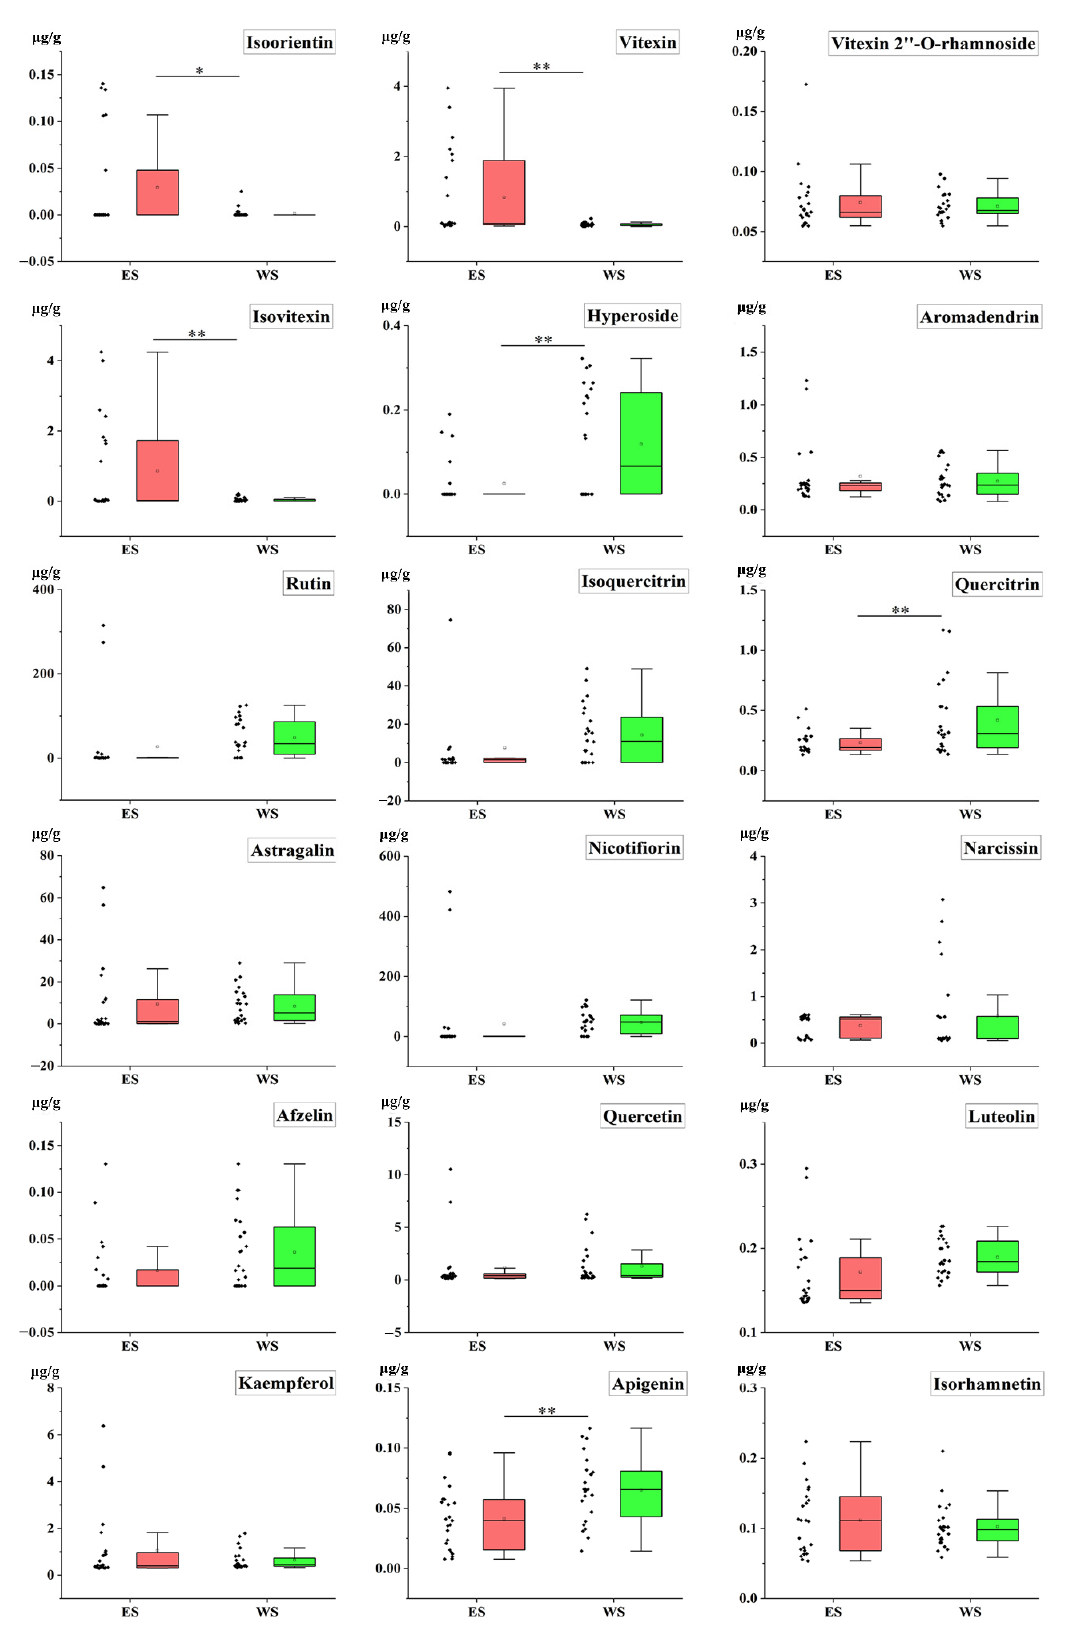
Figure 6. The box plot of 60 constituents’ contents in ES and WS (* p < 0.05, ** p < 0.01, *** p < 0.001).